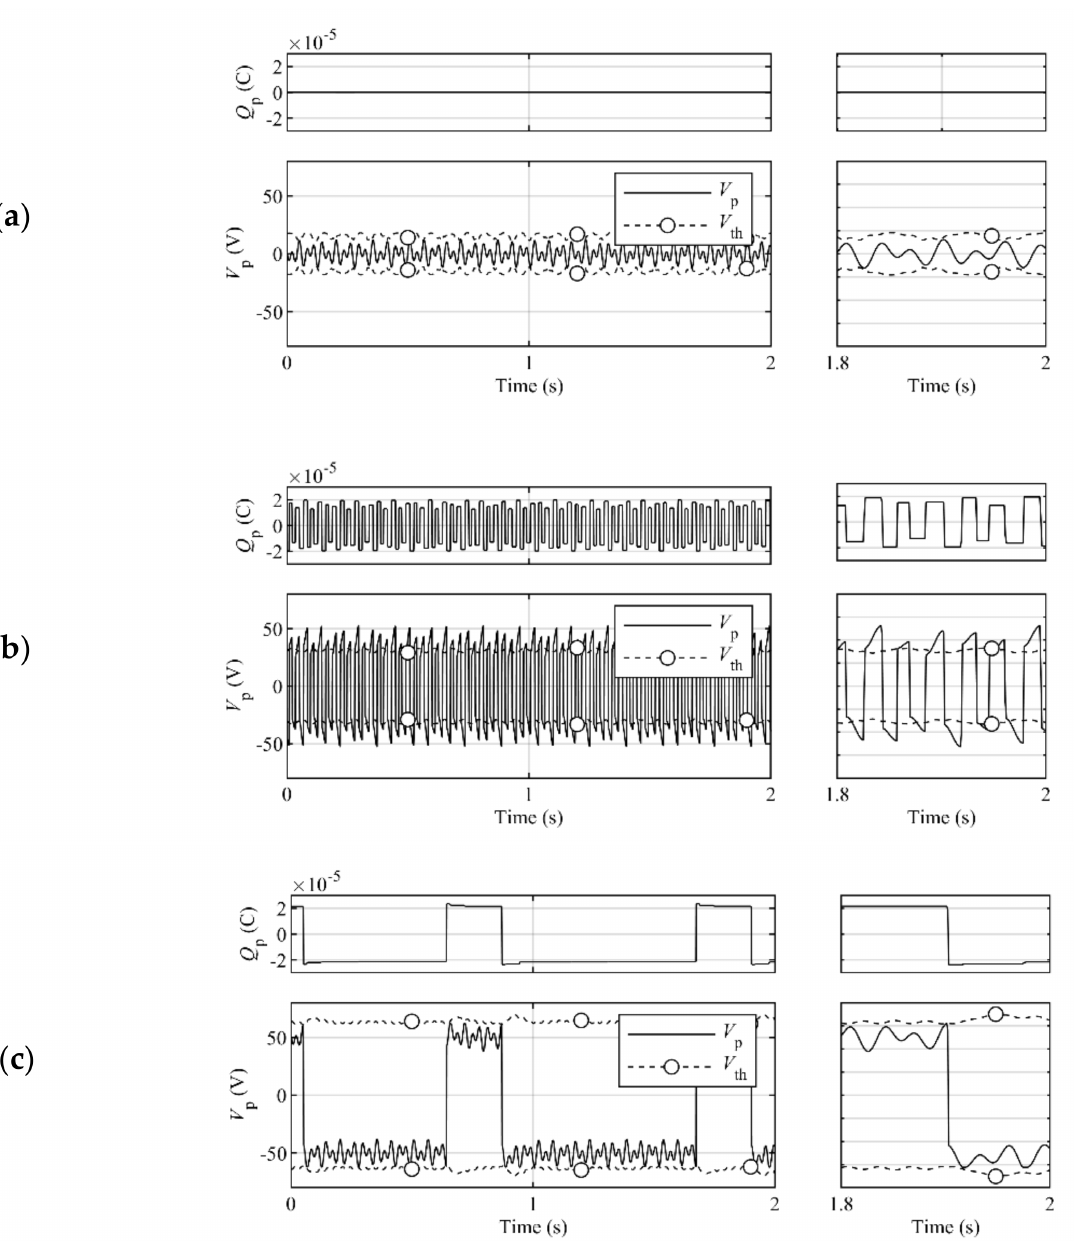
Figure 3. Time histories of the piezoelectric charge, and the piezoelectric voltage and the threshold under each control type. ( a ) The STDH control type, which occurs because of the exceedingly large threshold coefficient magnitude, does not perform switching actions. Although the charge moves slightly in accordance with the harvesting circuit state, the change in the charge under STDH conditions is hardly visible because the scale of the vertical axis is matched with the other control types. ( b ) The SSHI control type, which occurs because of the exceedingly small threshold coefficient magnitude, performs switching actions at all peaks. ( c ) The SCVS control type, which occurs because of the adequate threshold coefficient magnitude, accomplishes appropriate intermittent switching